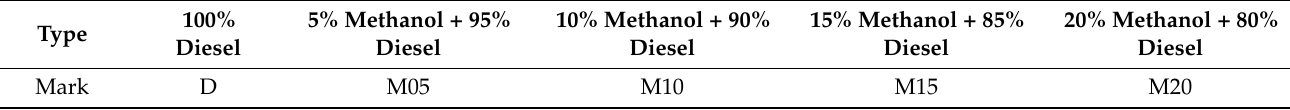
Table 3. Fuel types.